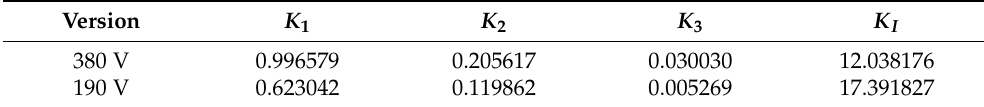
Table 8. Gain values for both vesions of Boost